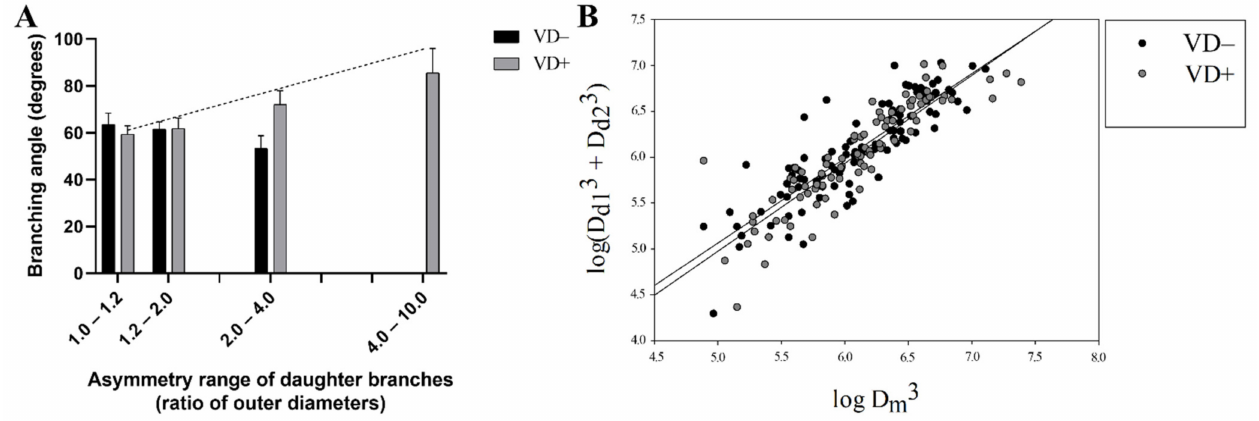
Figure 3. Analysis of branching. ( A ) Asymmetry range of daughter branches (ratio of outer diam- eters). The asymmetry index (with increasing branching angle) was significantly elevated only in VD+ groups (with Pearson correlation, p < 0.05). ( B ) The Murray law. Branches are obeying the Murray